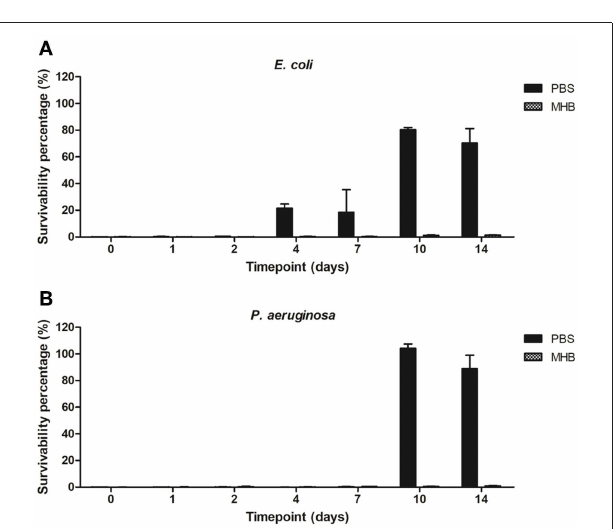
FIGURE 8 | Survivability percentage of planktonic cells of (A) E. coli and (B) P. aeruginosa in presence of solutions containing gentamicin released from the plasma coated steel coupons.